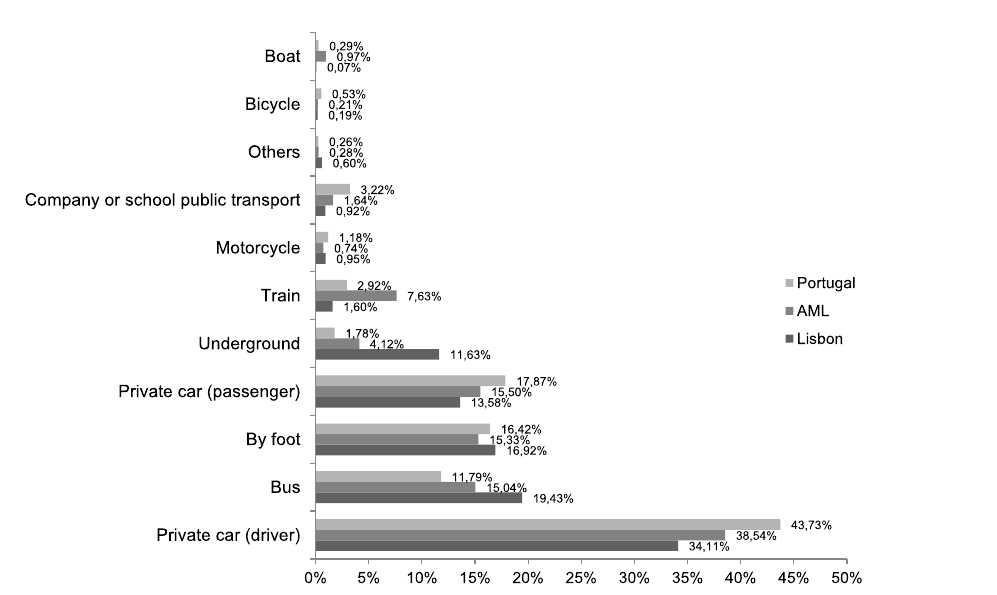
Figure 1. Modal share of commuting trips in Lisbon, LMA and Portugal (Source: INE, 2011) Fig.2 shows the existing and operating cycle network (red links), but also those under construction (orange) or currently under study (yellows). The existing cycle network (78 km of segregated cycle paths) was planned and designed mainly for leisure trips between green parks, gardens and some touristic sites. These paths were included in Lisbon’s ‘green corridors’, for example, along Tagus’ riverside and in the western part in the Monsanto forest (lighter green area indicated in Fig. 2). Noticeably, the city lacks a more encompassing cycle network, namely in the central areas. Recently, the municipality of Lisbon announced a few projects with clear prospects of increasing the number of cycle lanes in the city centre, for instance linking the campuses of the University of Lisbon and in the plateau area of Lisbon (refer to the green rectangle in Fig.2), besides the launching of a bike sharing system by December 2016. Still, there is no provision of a clear and formal global cycling network plan, yet.